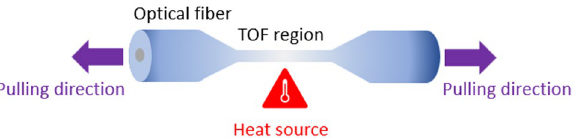
Figure 6. Schematic illustration of the heat and pull method for fabricating the tapered optical fiber.